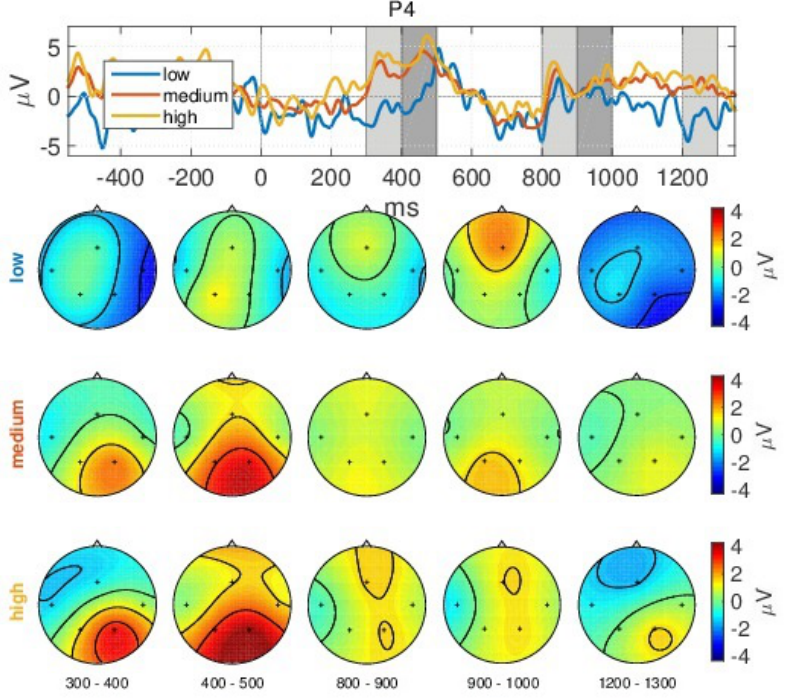
Figure 8. GA ERP for Nat images on three complexity levels according to participants subjective evaluation, at channel P4.